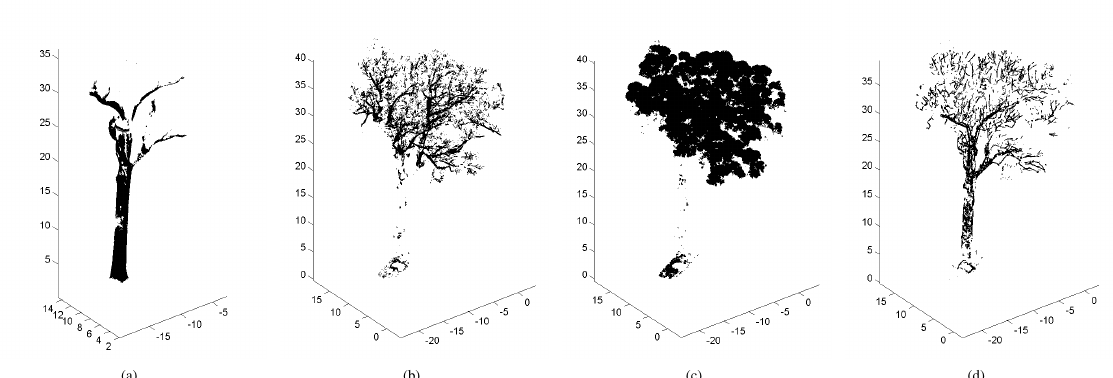
Figure 1: Merged clusters from GMM representing (a) main trunk, (b) branches, (c) leaves and (d) mixed points from trunk and branches